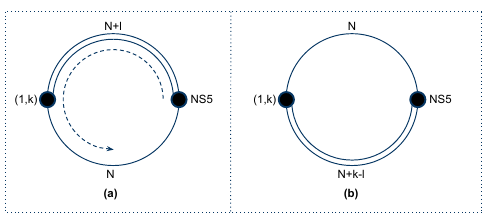
Figure 3 . Brane manipulations in type IIB string theory which yield a duality between Chern Simons theories of an elliptical quiver. An NS5 brane moves past a (1 ; k ) brane creating k and destroying l D3 branes in the process. Reproduced from